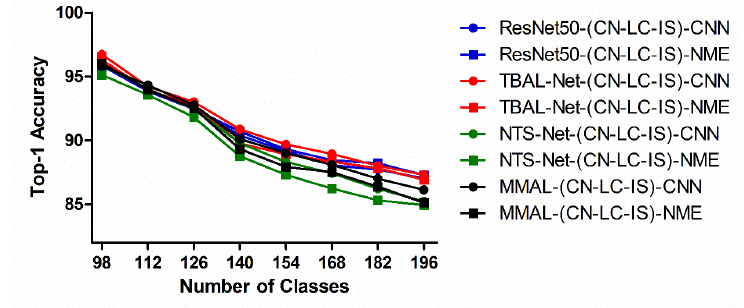
Figure 5. The performance of different number of incremental phases on FGVC-Aircraft.